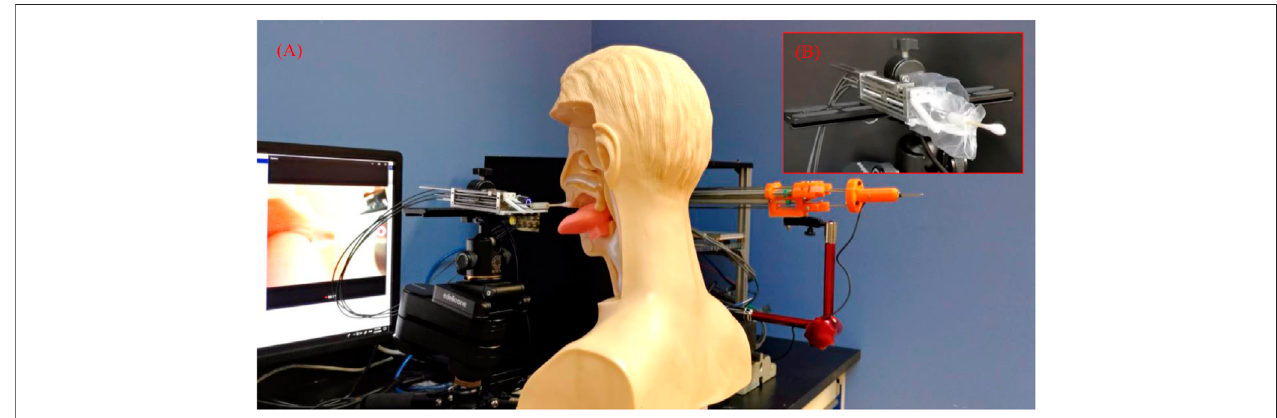
FIGURE 5 | Setup for the performance tests of the robot, (A) The setup of the robot, (B) The fl exible manipulator with sterilized wraps.